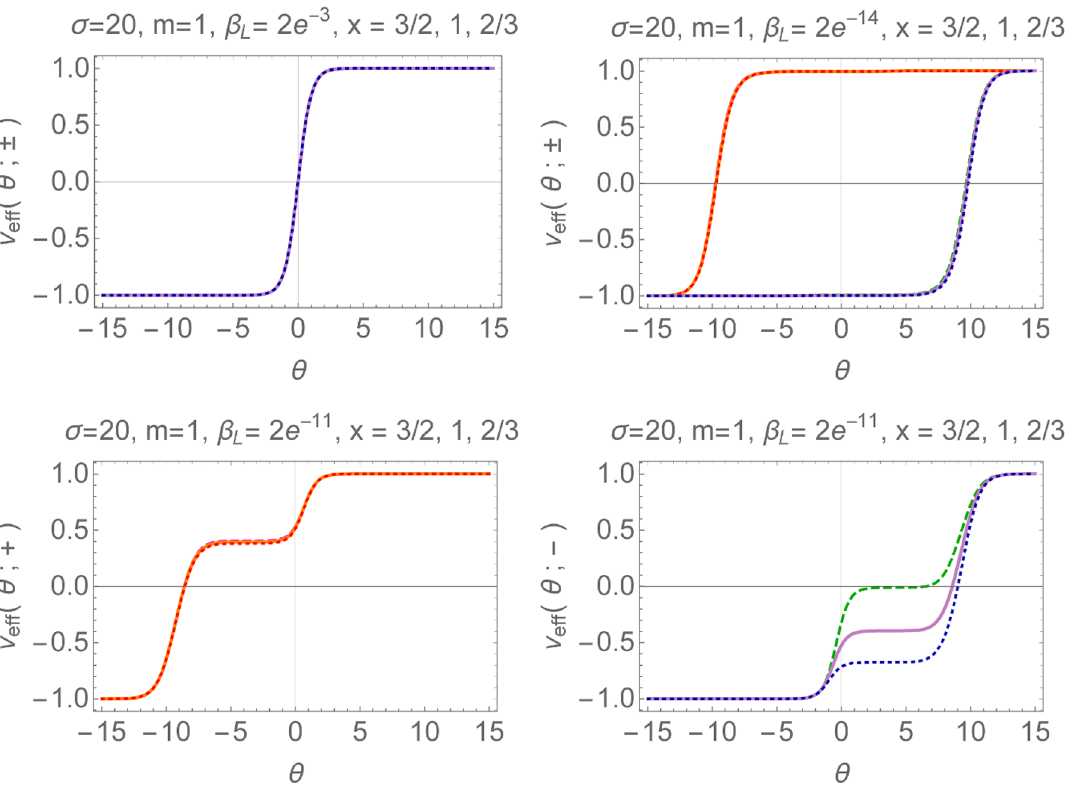
Figure 9 . Steady state e(cid:11)ective velocities for three values of (cid:12) L and three values of x , including (for comparison) the equilibrium case x = 1. The velocity pro(cid:12)les retain many of their equilibrium features. In the bottom right (cid:12)gure x = 3 (dashed, green), x = 1 (solid, pink) and x = 2 (dotted, 2 3 blue). The variation of the velocities with temperature can be further explored in this video [78].